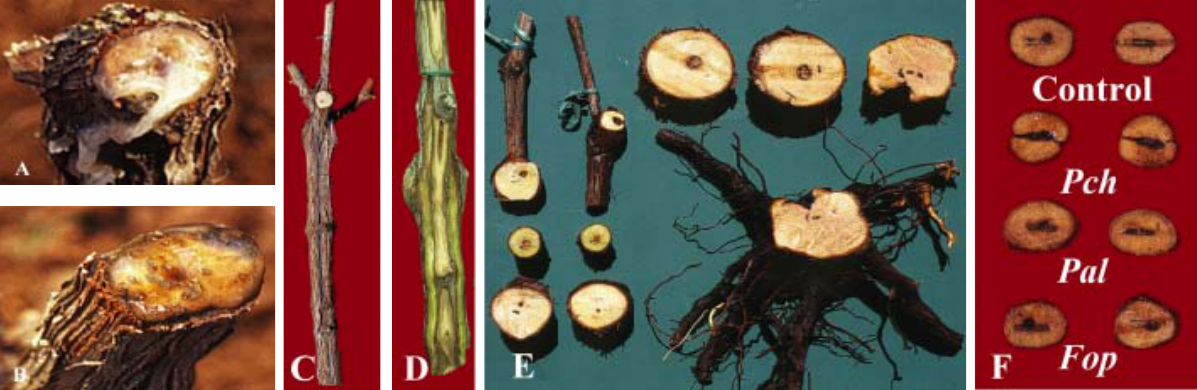
Fig. 2. Symptoms on 6-year-old grapevines cv. Italia infected with Phaeomoniella chlamydospora ( Pch ) or Phaeoa- cremonium aleophilum ( Pal ): A. cross-section of trunk showing gummy flow, 28 months after inoculation with Pch, or, B. with Pal ; C. 3-year-old canes 30 months after inoculation of the spurs with Pch, showing sunken bark; D. 3- year-old canes 30 months after inoculation of the spurs with Pal , showing browning of the bark; E. cross sections of canes, trunk and roots of vines, 30 months after inoculation of the spurs with Pch ; F. cross sections of inoculation holes drilled radially through the trunk into which wood dowels colonised by Pch and Pal were inserted, 32 months after inoculation. Within three years, the inoculation wounds of Pal , Fop and control, but not of Pch , were sealed by the annual